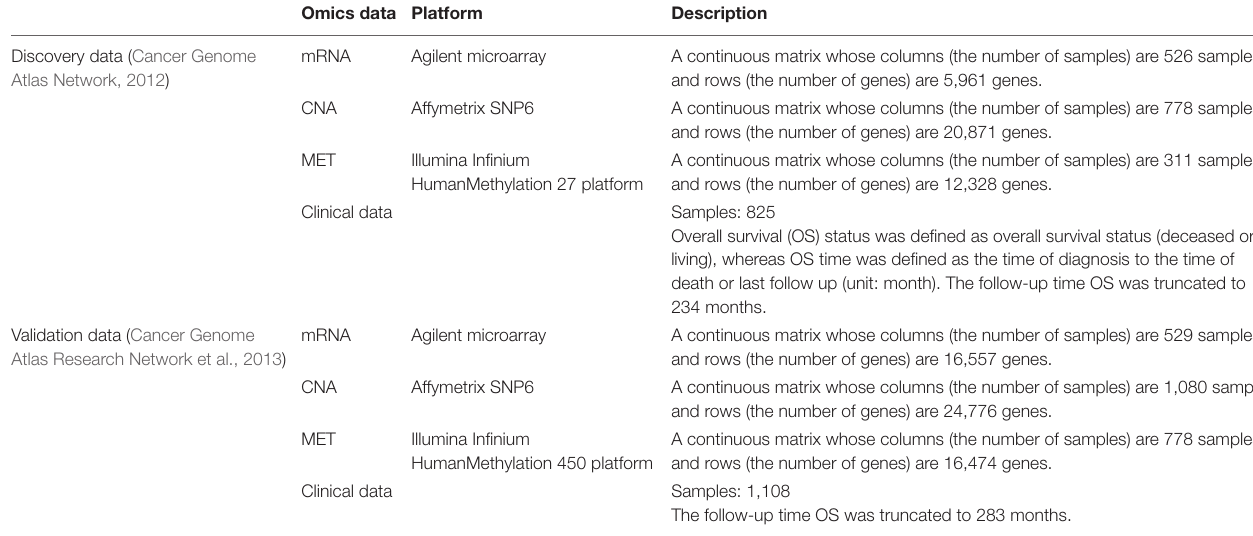
FIGURE 1 | Analysis protocol. First, CNA, MET, and mRNA datasets were inputted to the function “ geneCor ” to identify a list of CNAcor and METcor genes. Then, we detected prognostic subgroups for individual CNAcor and METcor datasets, and a combination of CNAcor + METcor + mRNA through single and integrated analyses using PINPlus, respectively. Next, several analysis results (i.e., relationships between CNAcor or METcor with their corresponding mRNA, association of CNAcor or METcor with overall survival (OS) of BRCA patients, integrative clustering analysis, and comparison between the PAM50 subtypes and our integrative subgroups) were validated by an independent dataset. Finally, we examined the relationships between our classification system and the PAM50 subtypes before characterizing our subgroups using the R package GeneCluster. hclust, hierarchical clustering method. TABLE 1 | Description of two breast cancer